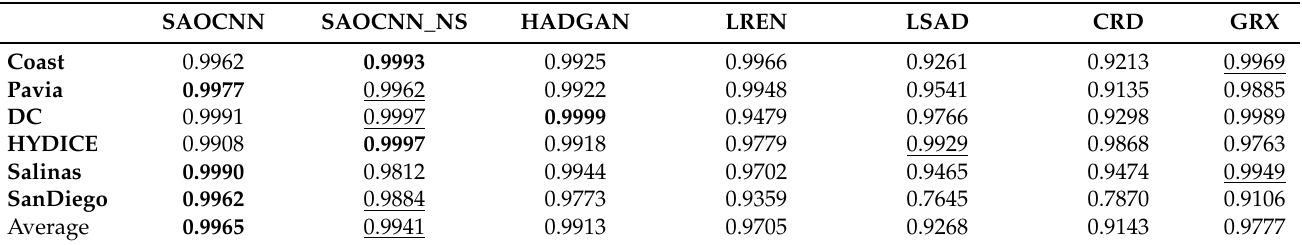
Table 1. AUC f of SAOCNN, SAOCNN_NS, HADGAN, LREN, LSAD, CRD, and GRX. (The maxi- mum is in bold and the second largest is underlined).